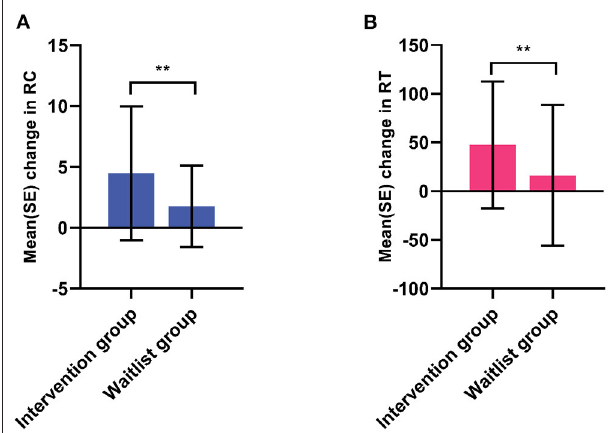
FIGURE 2 | Analysis of Go/No-Go task. The mean change of accuracy (A) and reaction time (B) of enrolled students in GEF-OPT intervention group ( n = 73) and waitlist group ( n = 72) were analyzed using Student t -test. Significant differences were found in difference of accuracy ( P = 0.001) and reaction time mean change ( P = 0.007) between intervention group and waitlist group. RC, accuracy; RT, reaction time; ** P <